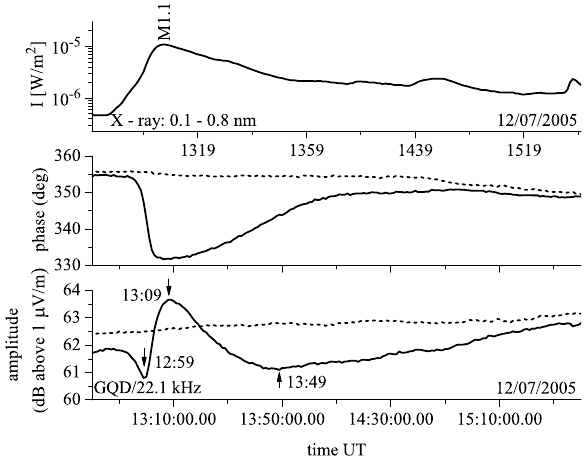
Fig. 5. Time variation of X-ray irradiance, GQD signal phase and amplitude during M1.1 (13:06UT) event on 12 July 2005 solid lines. Extrema indicated by arrows and the corresponding UT. Phase and amplitude on the quiet day 8 July 2005 – dashed lines.